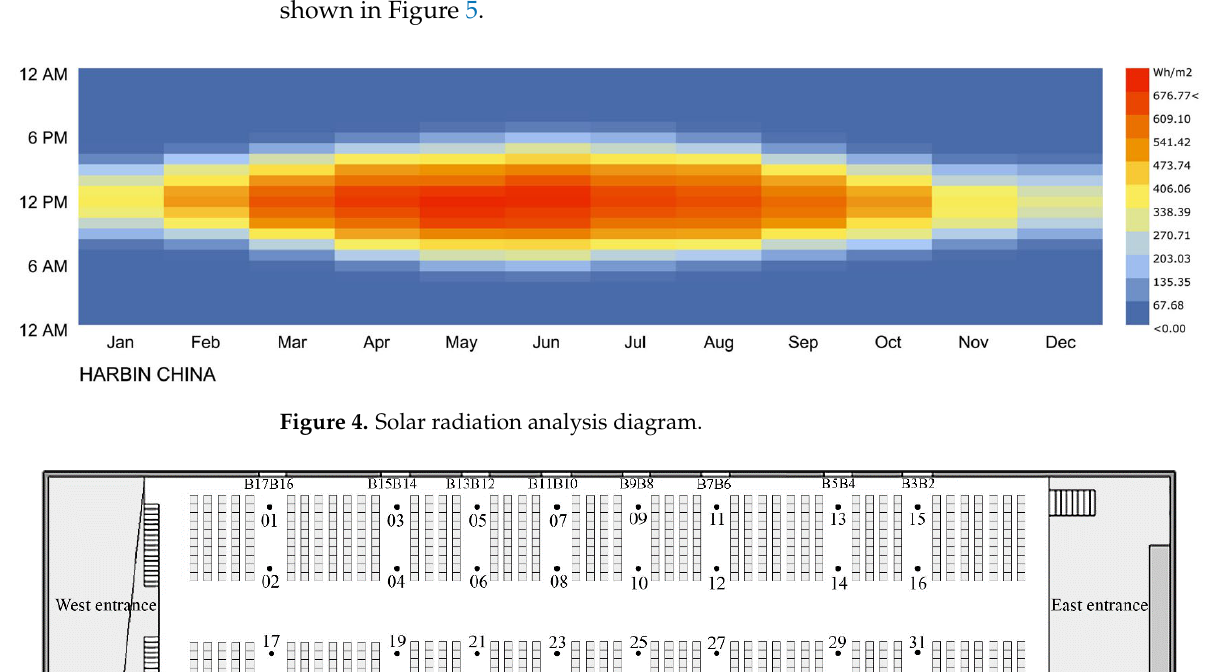
Figure 5. Layout of measuring points.